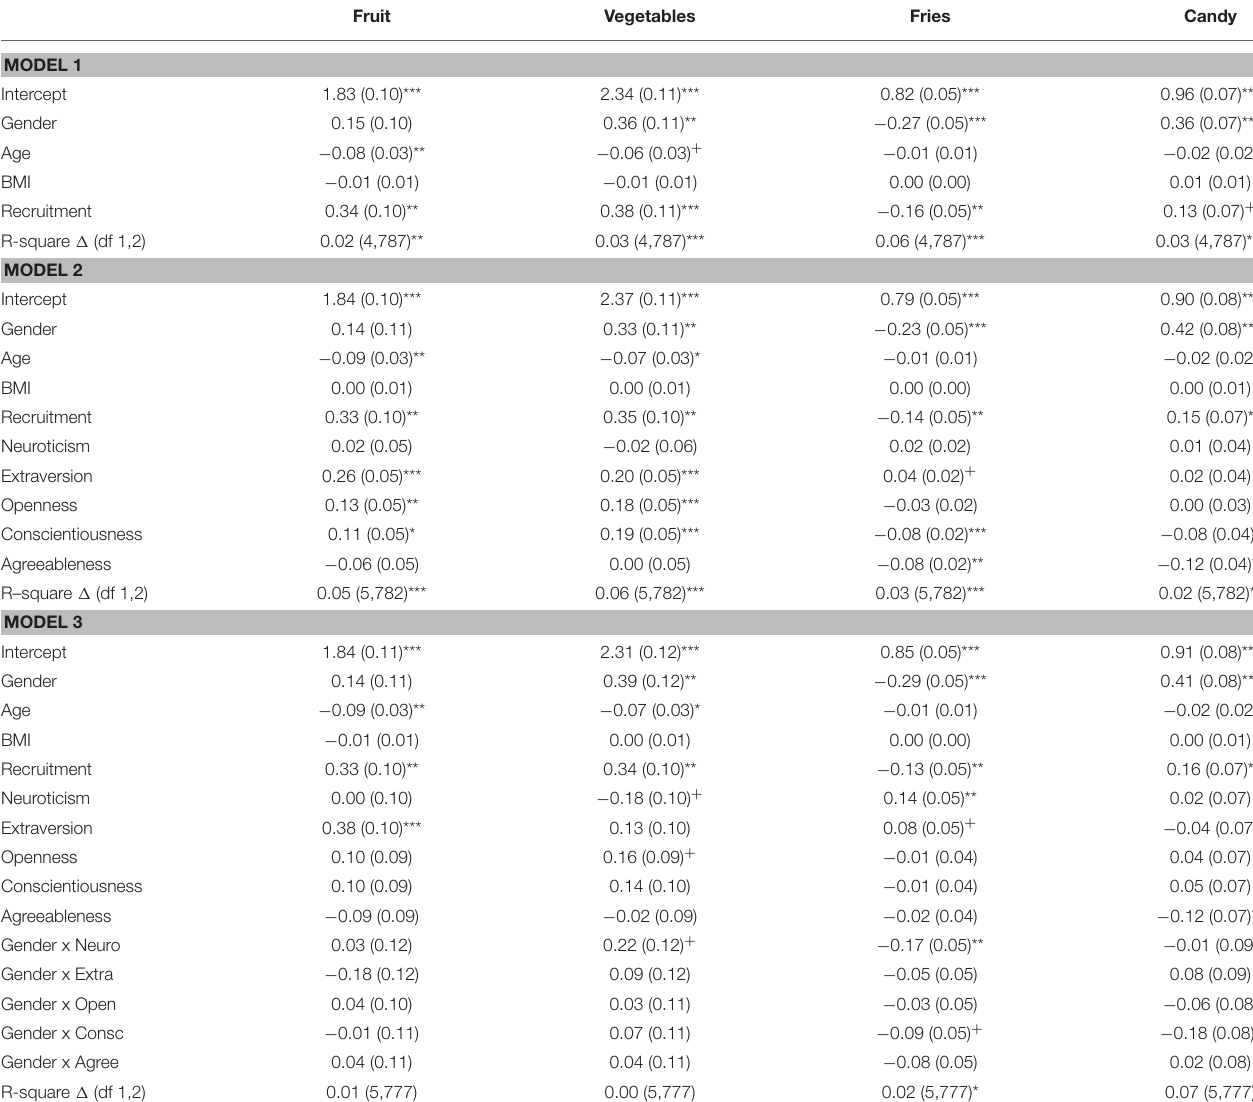
TABLE 3 | Results of hierarchical regression analyses predicting young adults’ fruit and vegetable consumption and unhealthy foods in Sample 2 ( N = 792). Fruit Vegetables Fries